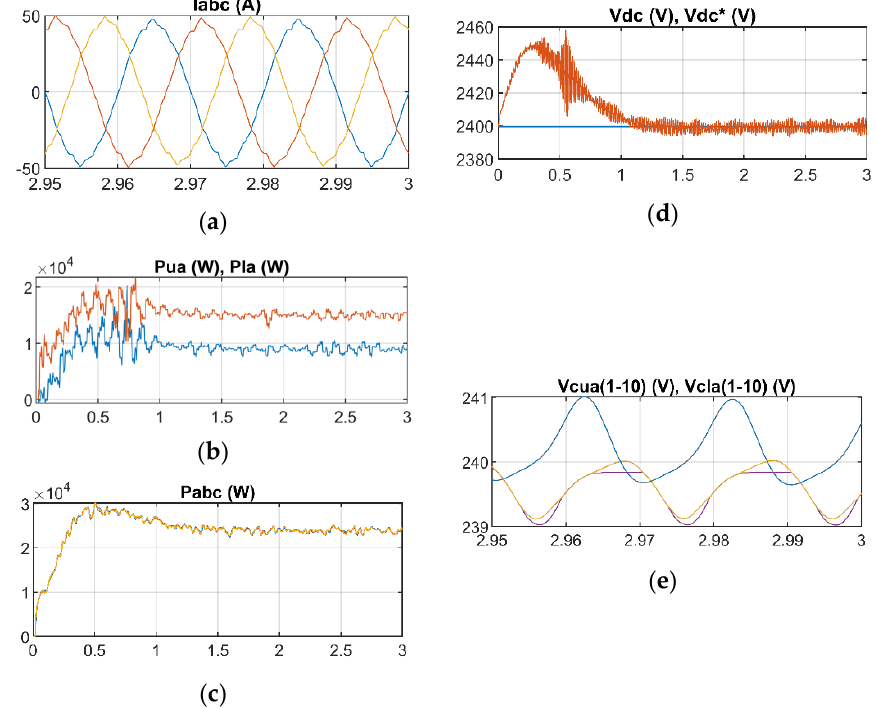
Figure 11. Simulation plots when the generation has an intermediate imbalance between arms. ( a ) Output currents. ( b ) Power of the upper and lower arms. ( c ) Power delivered by each phase. ( d ) Voltage on the DC link. ( e ) Capacitor voltages.